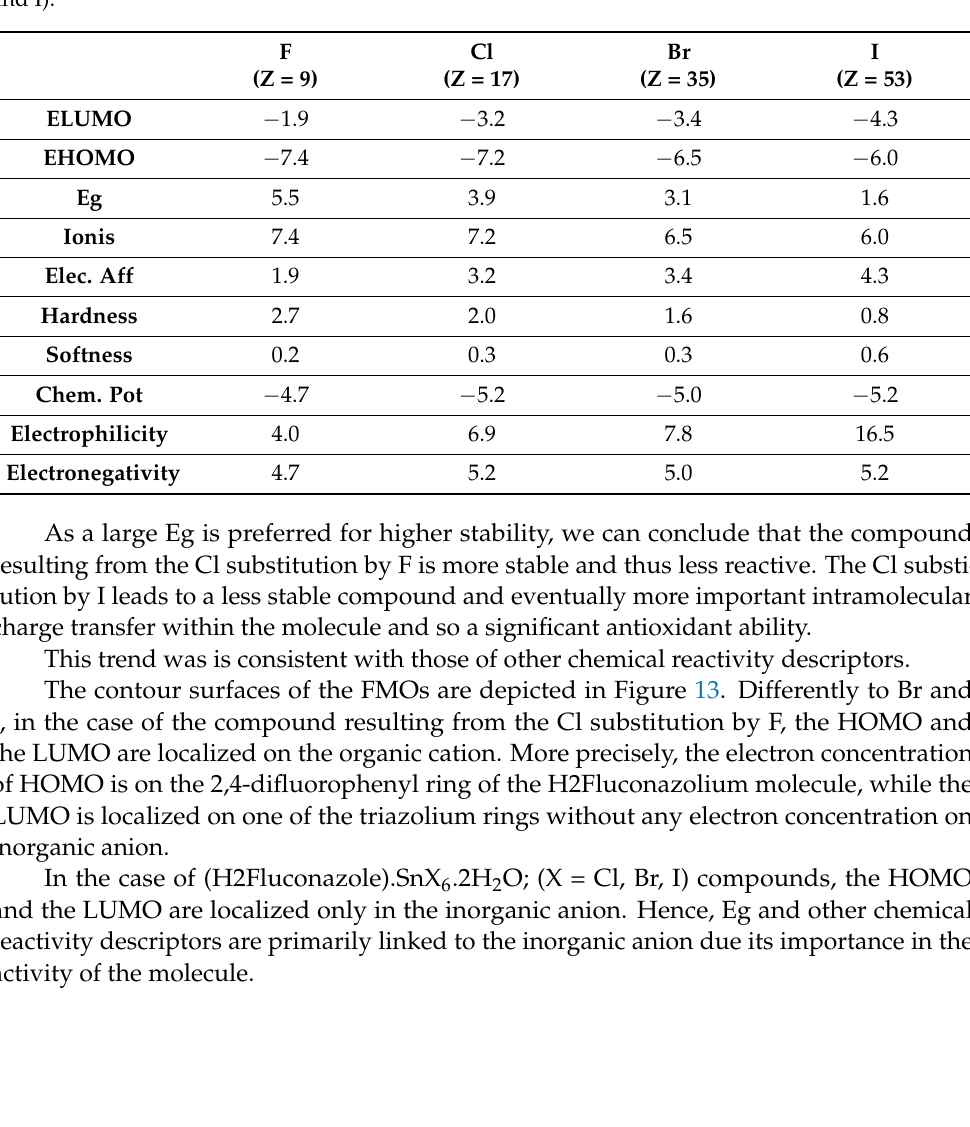
Table 5. Global reactivity descriptor values (in eV) of (H2Fluconazole).SnX 6 .2H 2 O; (X = F, Cl, Br, and